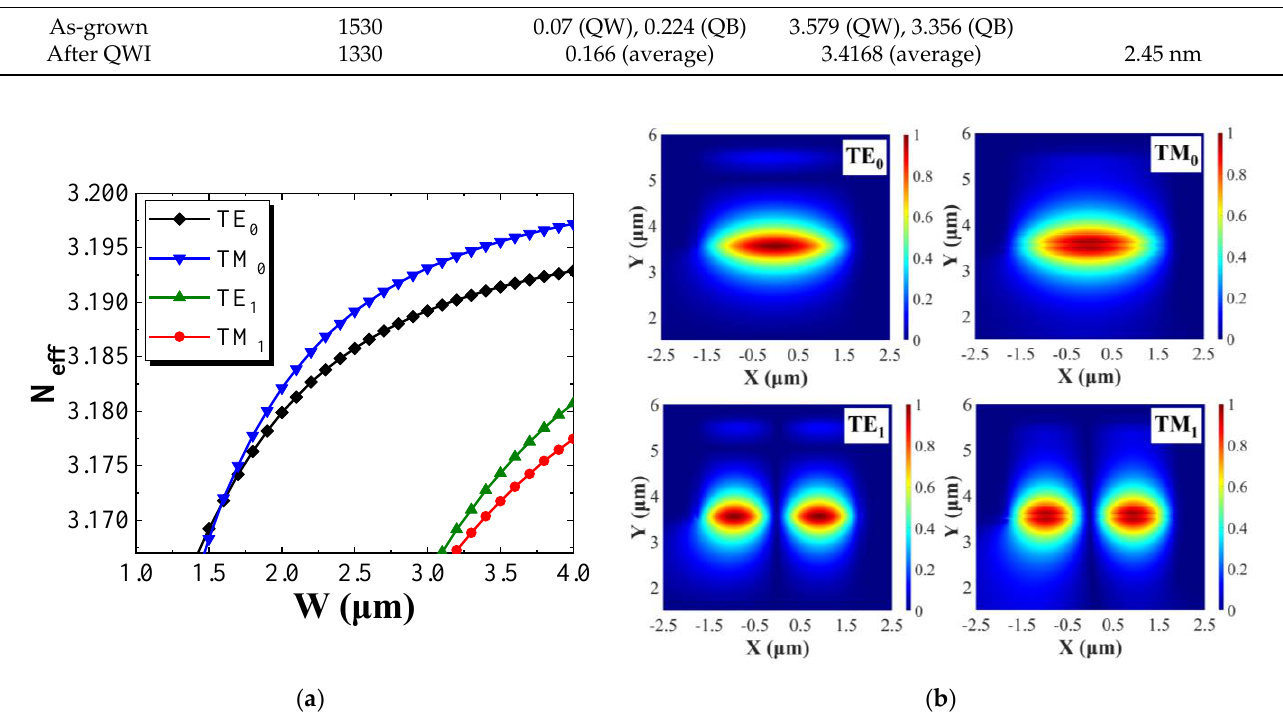
Figure 4. ( a ) Simulated waveguide effective refractive index of TE 0 , TM 0 , TE 1 , TM 1 modes as a function of the ridge waveguide width W with D 1 = 2.16 μm and D 2 = 3.64 μm . ( b ) Electric field profiles of TE 0 and TM 0 , TE 1 and TM 1 modes ( W = 3.50 μm).